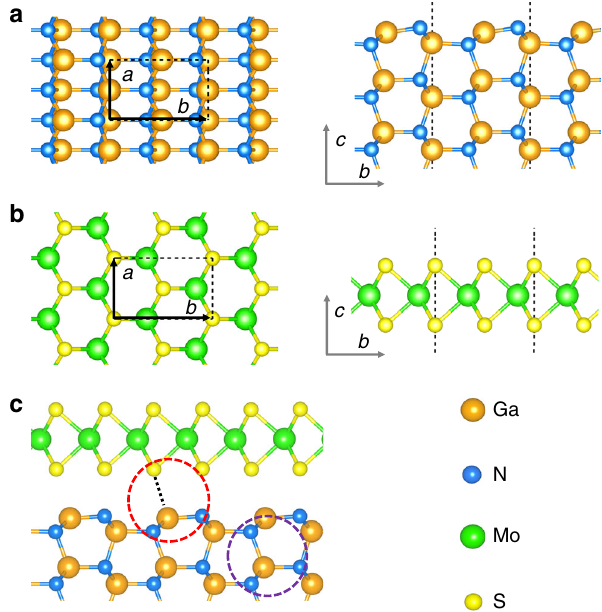
Fig. 1 Calculated atomic structures. Top and side view of the fully relaxed atomic structures of a GaN (10 (cid:1) 10)-wurtzite and b MoS 2 . c Top view of the fully relaxed atomic structures of MoS 2 /GaN (10 (cid:1) 10) vertical